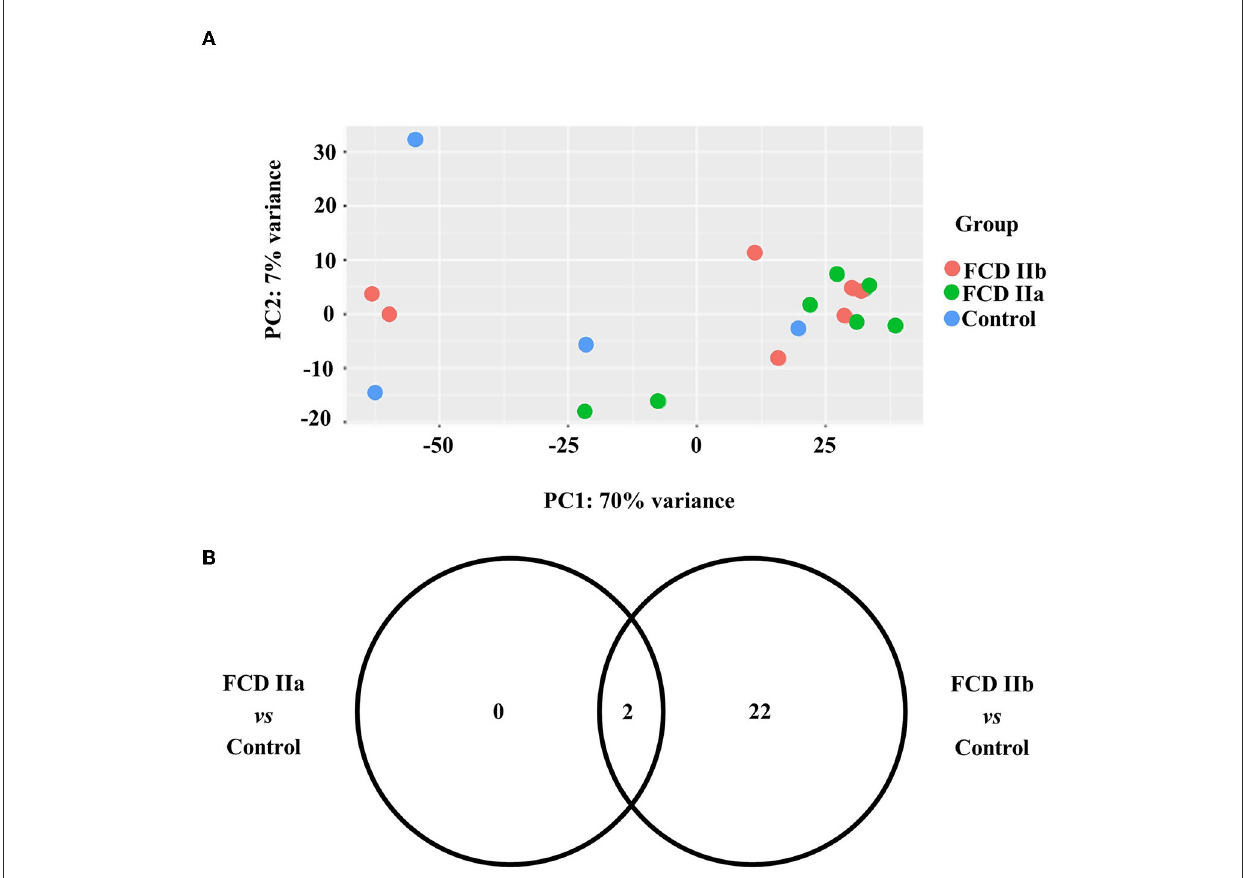
FIGURE5 Gene expression analyses of the white matter of autopsy (control), focal cortical dysplasia (FCD) ILAE type IIa (FCD IIa) and FCD ILAE type IIb (FCD IIb) groups. (A) Graphical presentation of gene expression data after analyses performed with the PCA dimensionality reduction method. Brazilian and German FCD specimens with the same histopathological classification are shown as one group (FCD IIa or FCD IIb). Samples with the same neuropathological diagnosis did not cluster together. (B) Venn diagram showing the number of differentially expressed genes in each group compared to controls. FCD IIa and FCD IIb groups showed 2 and 24 differentially expressed genes, respectively. Two genes were common to FCD IIa and IIb groups. The highest number of exclusively differentially regulated genes was verified in FCD IIb (20). Additional data on gene expression are reported in the Supplementary material.